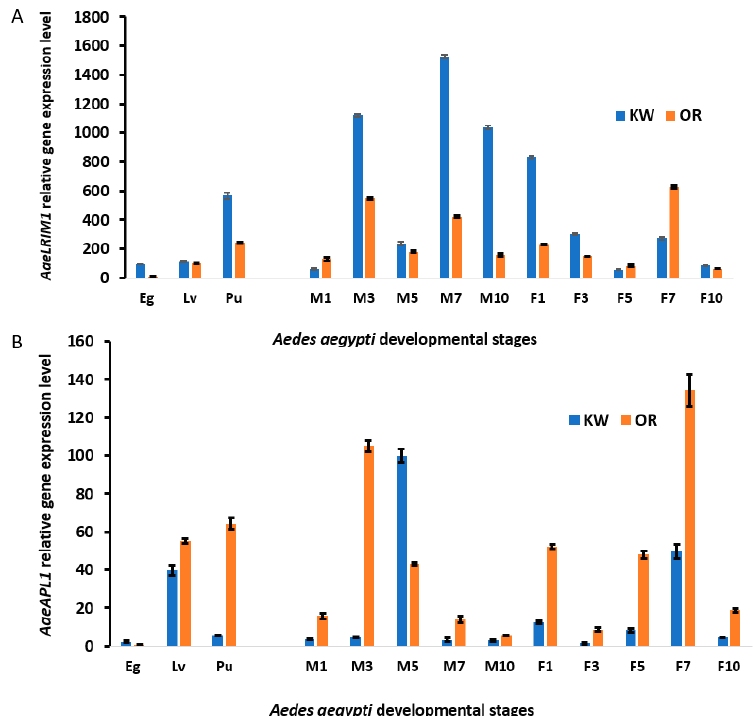
Figure 1. AaeLRIM1 and AaeAPL1 relative expression in the all developmental stages, from eggs (Eg), 152 larvae (Lv), pupae (Pu), and adults Ae. aegypti , including male (M1, male 1-d-old; M3, male 3-d-old; 153 M5, male 5-d-old; M7, male 7-d-old; and M10, male 10-d-old) and female (F1, female 1-d-old; F3, 154 female 3-d-old; F5, female 5-d-old; F7, female 7-d-old; and F10, female 10-d-old) in the Key West strain 155 (KW) and Orlando (OR) strain of Aedes aegypti . ( A ) AaeLRIM1 ; ( B ) AaeAPL1 . 156